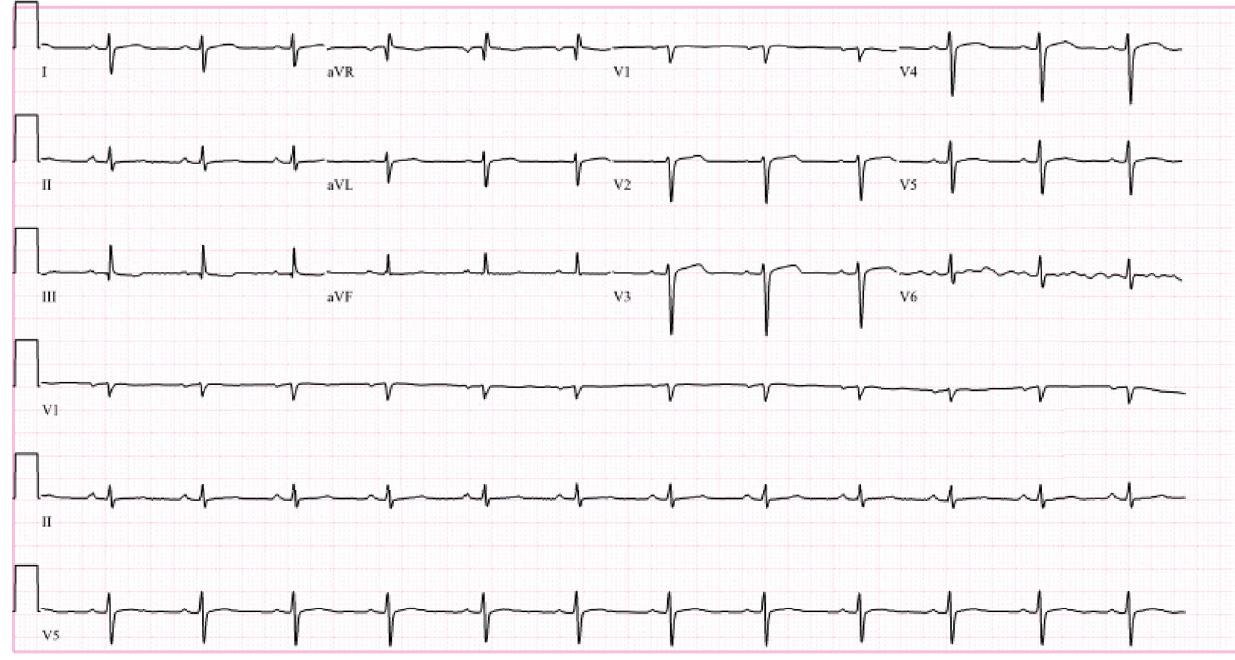
Figure 2: EKG showing normal sinus